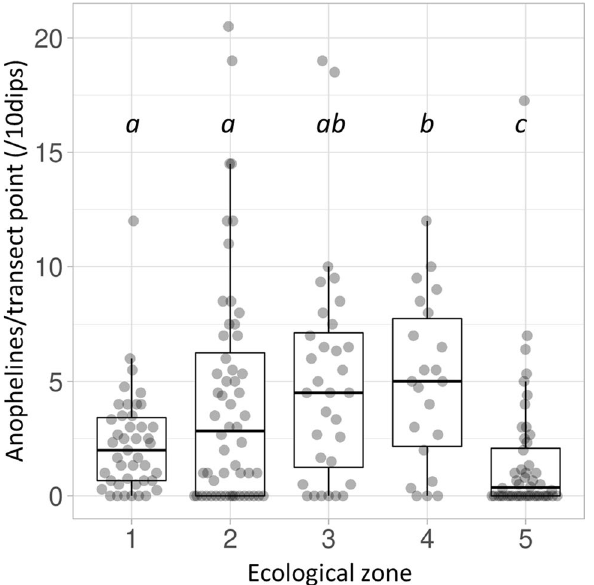
Figure 2. Anopheline larval abundance within 5 defined ecological zones (see Fig. 1 and Methods) in western Zambia. 1 = Zambezi floodplain; 2 = Floodplain edge; 3 = Luena flats; 4 = Lui valley; 5 = dambos. Total value per transect point (standardised per 10 dips) represented by dots; boxplot indicates interquartile range and median (horizontal line), with whiskers extending to minimum and maximum values within 1.5 times IQR. Transect points n = 220; anophelines n = 1557. Median values for ecological zones that do not share a letter are significantly different (independent-samples median test with stepwise step-down comparisons; adjusted p < 0.001).